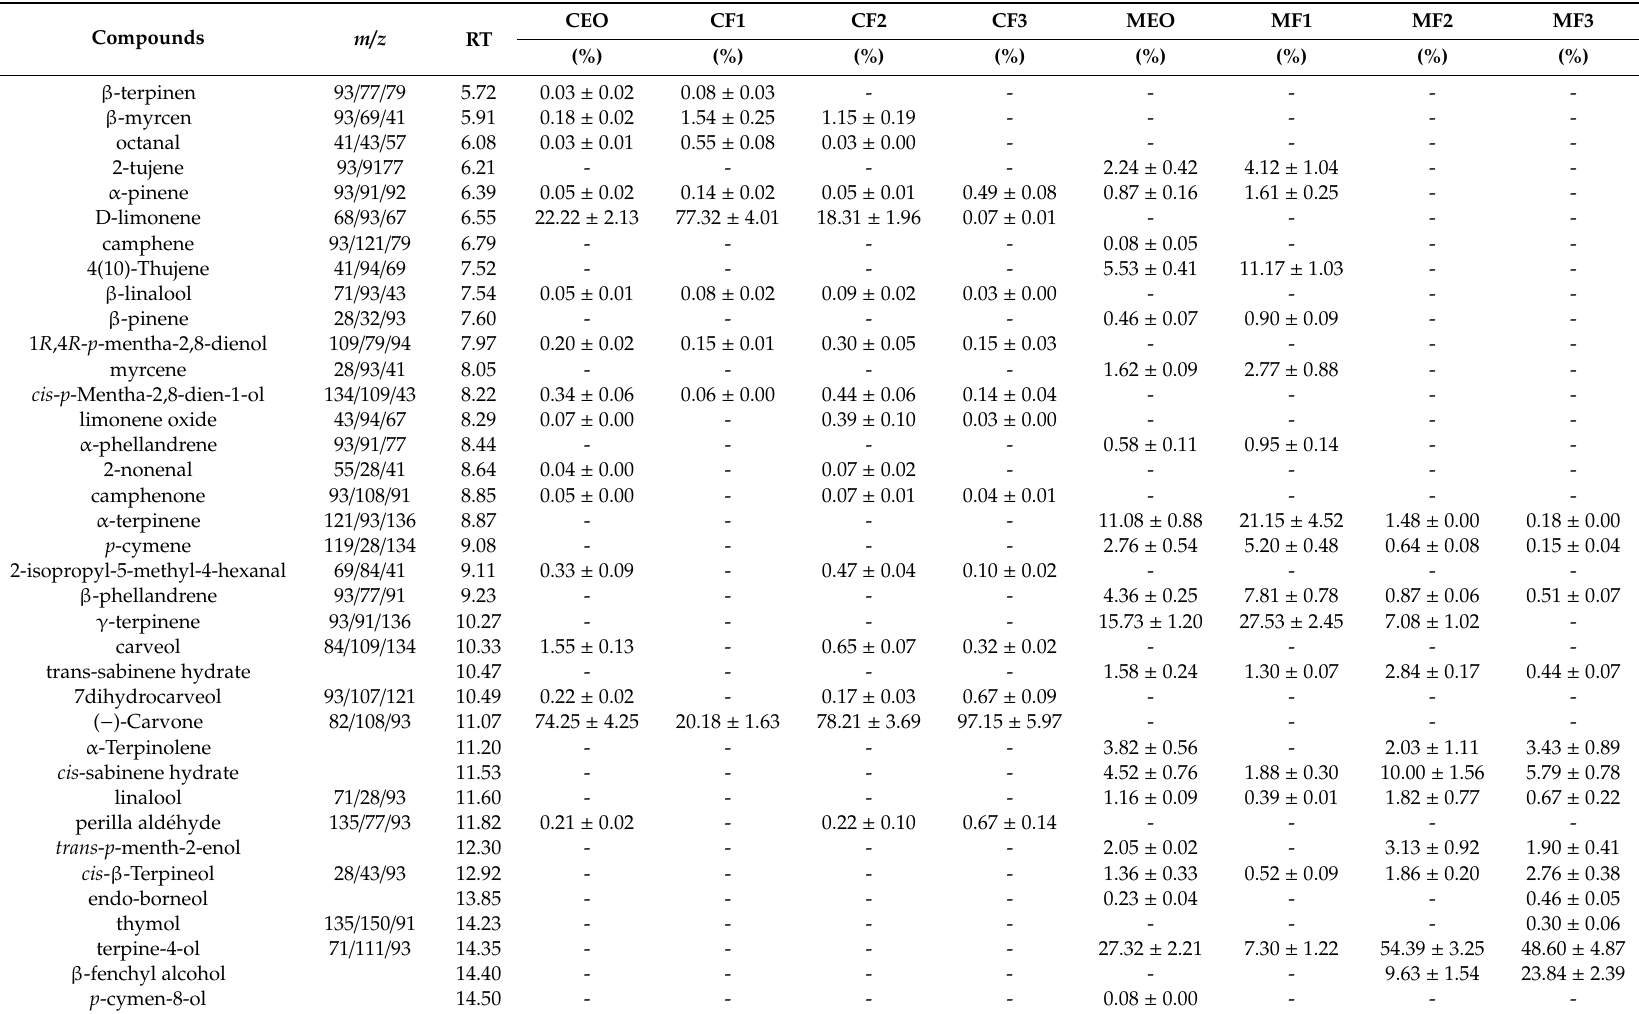
Table 1. Chemical composition of essential oils and fractions identified by the gas chromatography–mass spectrometry (GC-MS). Compounds